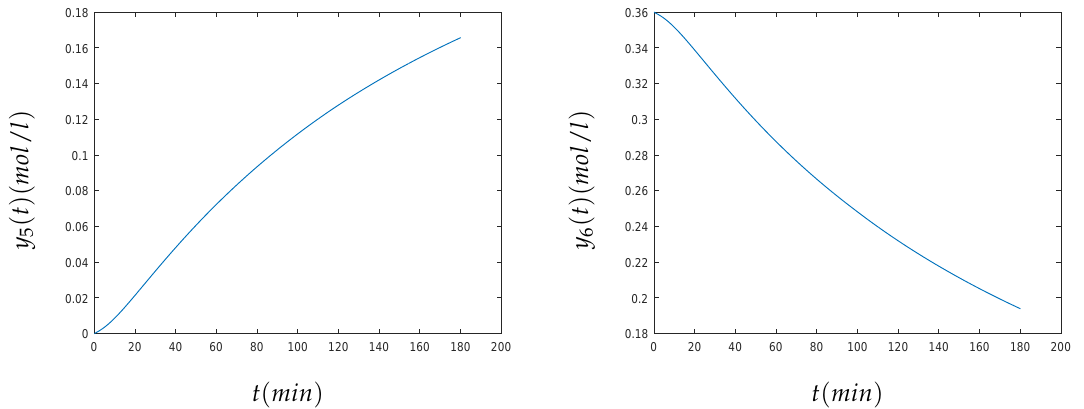
Figure 4. Numerical solution of the concentrations y 1 ( top left ), y 2 ( top right ), y 3 ( center left ), y 4 ( center right ), y 5 ( bottom left ), and y 6 ( bottom right ) of the chemical Akzo Nobel problem (4) for t ∈ [ 0,180 ]